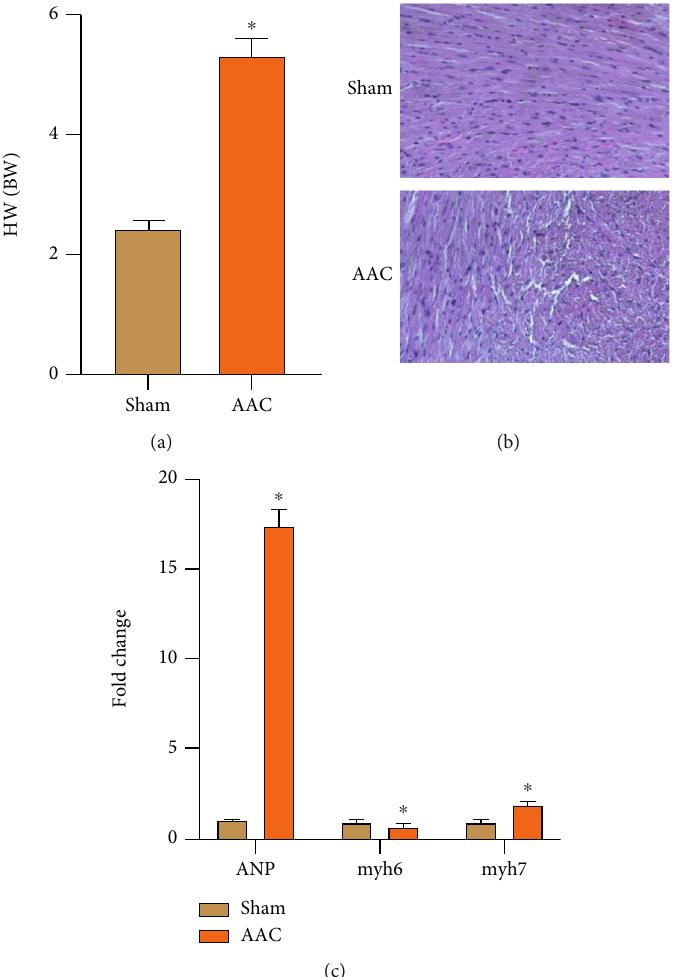
Figure 1: Identi fi cation of rat model of abdominal aortic coarctation and hypertrophy. (a) The rate of HW/BW in sham and AAC groups ( “ ∗ ” indicates statistical di ff erence from the sham group P < 0 : 05 ). (b) HE staining of renal tissues in sham and AAC groups (200x). (c) The expression of ANP, myh6, and myh7 in the sham and AAC groups ( “ ∗ ” indicates statistical di ff erence from the sham group P < 0 : 05